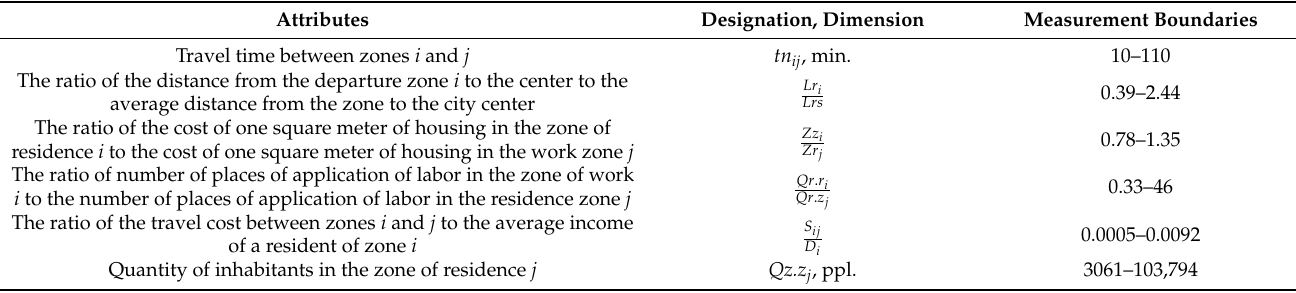
Table 1. Limits of measurement of the model of the trip distribution function of employees of city-service